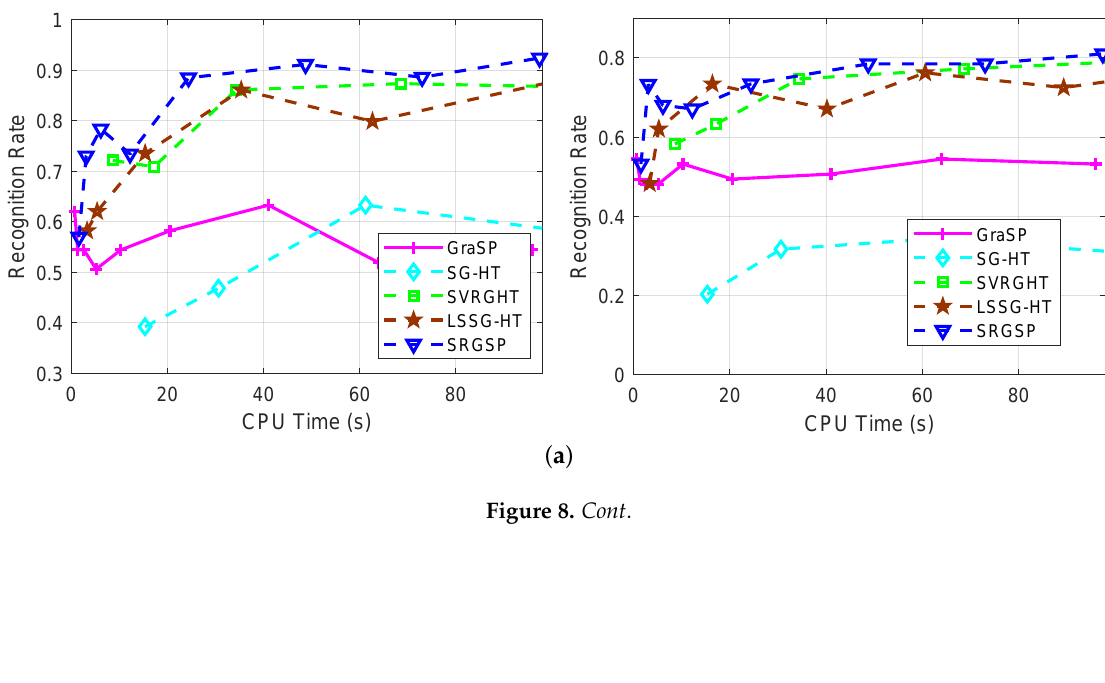
Figure 7. Examples of the AR face database with different levels of white Gaussian noise. ( a ) σ = 0; ( b ) σ = 0.25; ( c ) σ = 0.5.